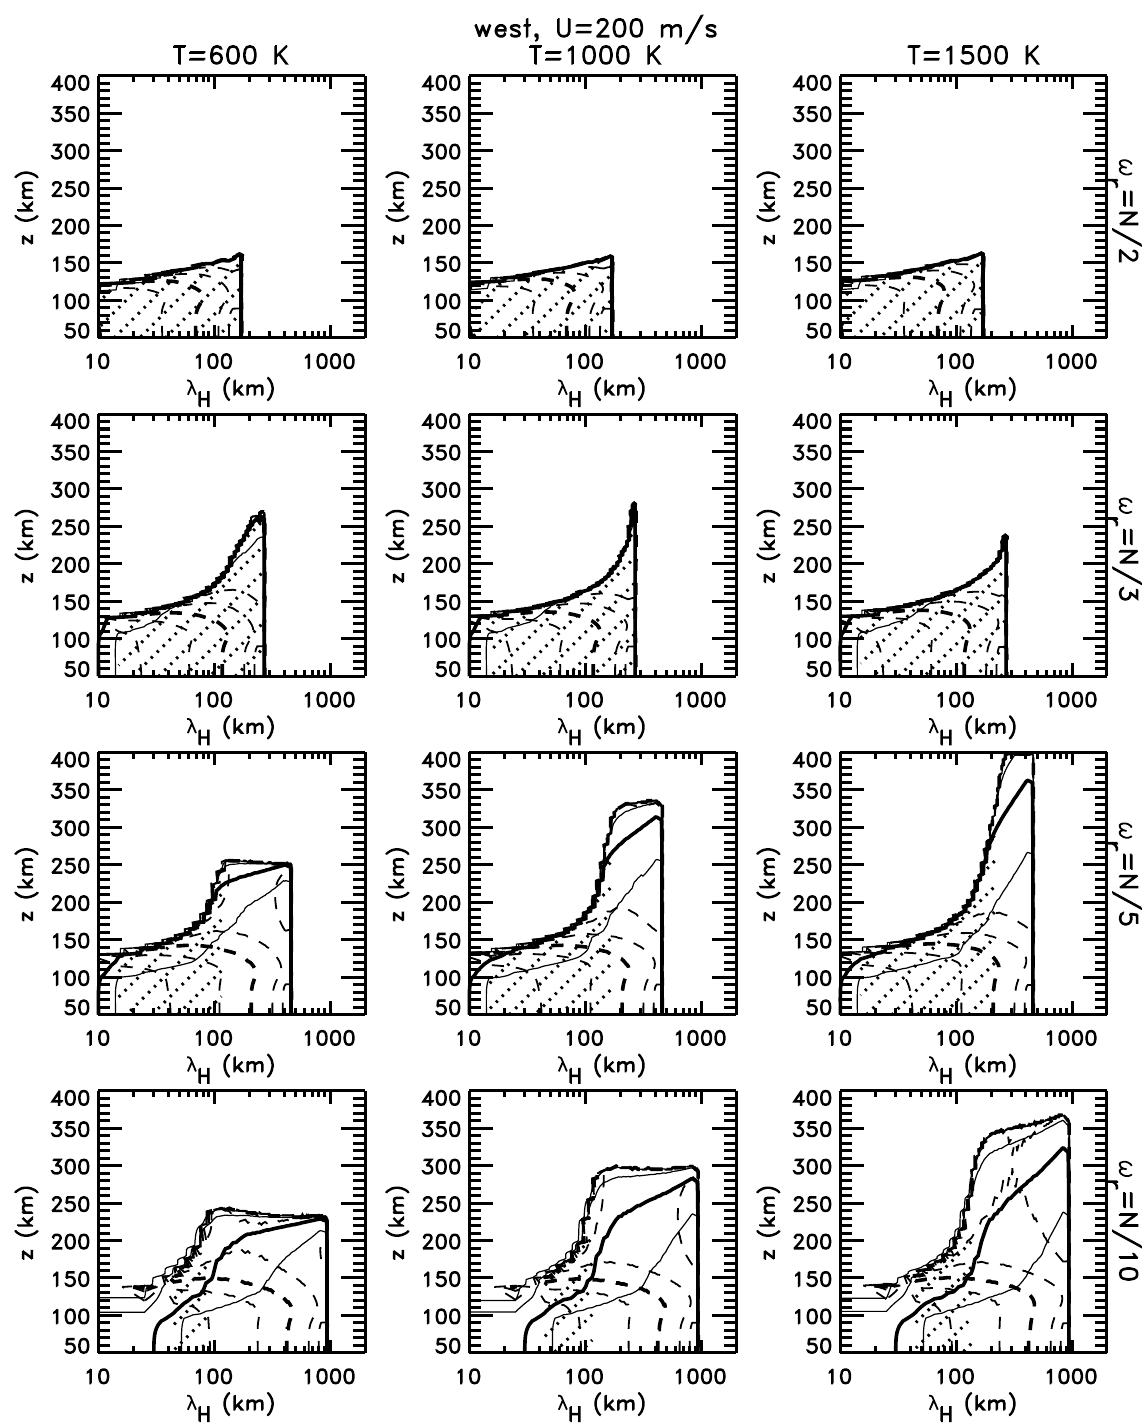
Fig. 5. As in Figs. 2 to 4, but for westward-propagating (up-shifted) GWs for minimum, mean, and maximum solar forcing (left, middle, and right columns, respectively) with an eastward thermospheric wind of 200ms − 1